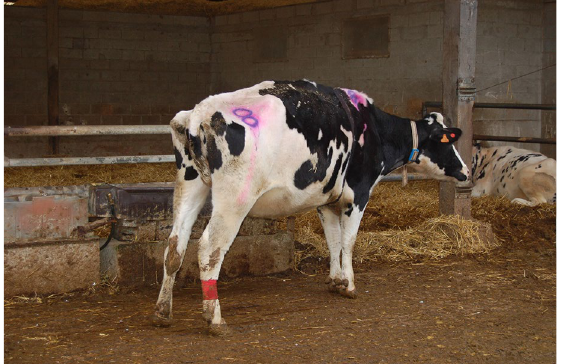
Figure 3. Cow displayed a hunched back, with hindlegs extended and tail pressed against vulva and udder.